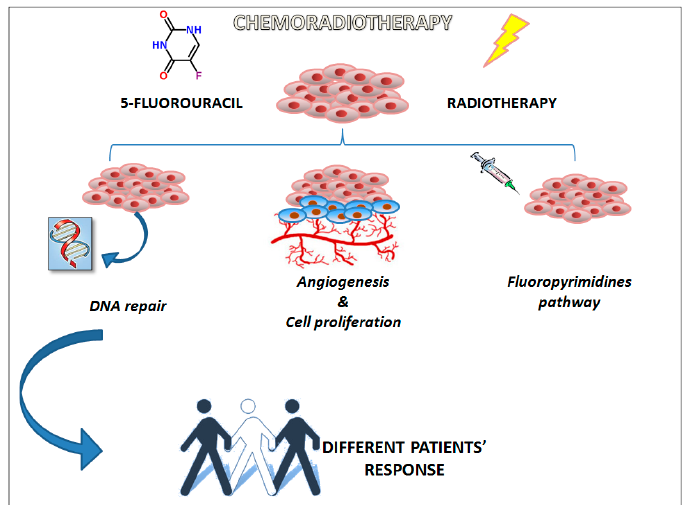
Figure 2. Pathway-based approach guiding this study. Response to fluoropyrimidine-based chemoradiotherapy is a complex phenomenon that is orchestrated by genes involved in many cellular mechanisms. Some key players are represented by DNA repair system, proliferation (blue cell) and angiogenesis, fluoropyrimidines response.